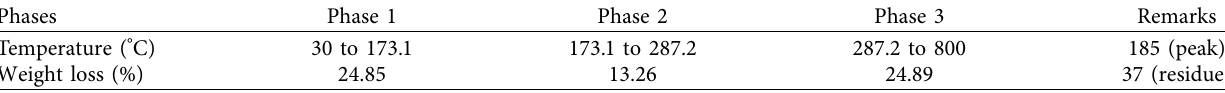
Table 2: Different stages of the TGA for Caulerpa lentillifera .